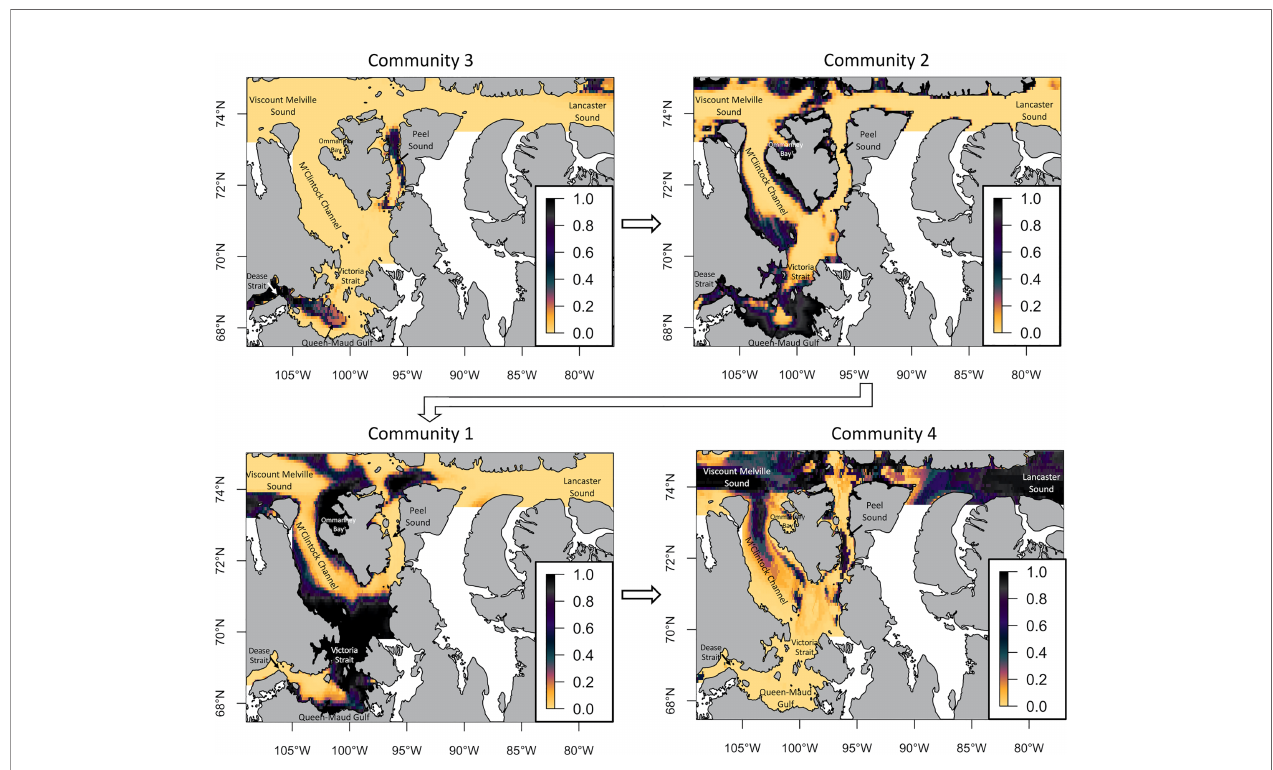
FIGURE 5 | Habitat suitability of 4 infaunal groups in the Kitikmeot sea region and Parry Channel regions obtained with GLMs. The scale from 0 to 1 represents the probability of occurrence of each community. The arrows show the gradient of species community distribution from Dease Strait to Lancaster